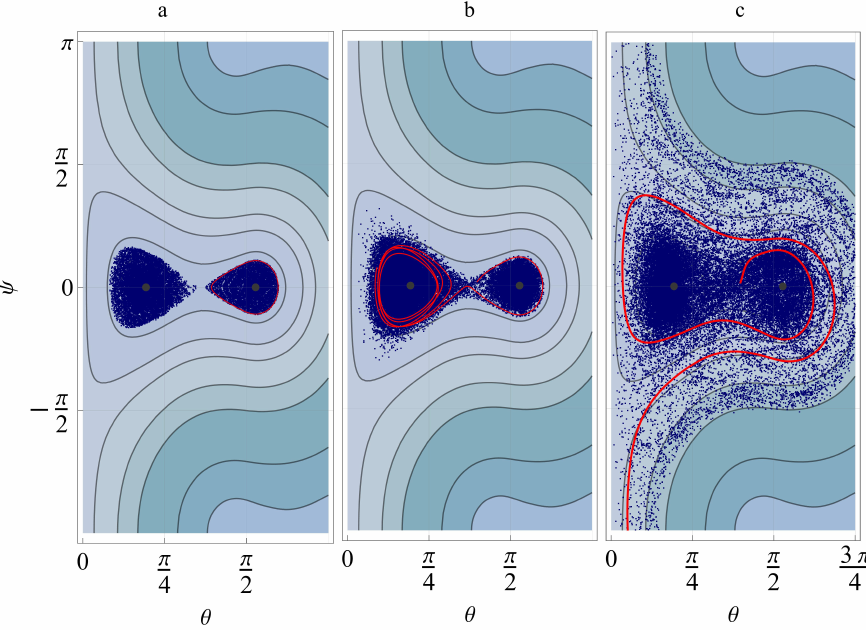
Figure 8. Poincaré sections ( h = 250 km, β = 33,000); ( a ): ε = 0, ( b ): ε = 580, ( c ): ε = 3900. Red lines: typical phase